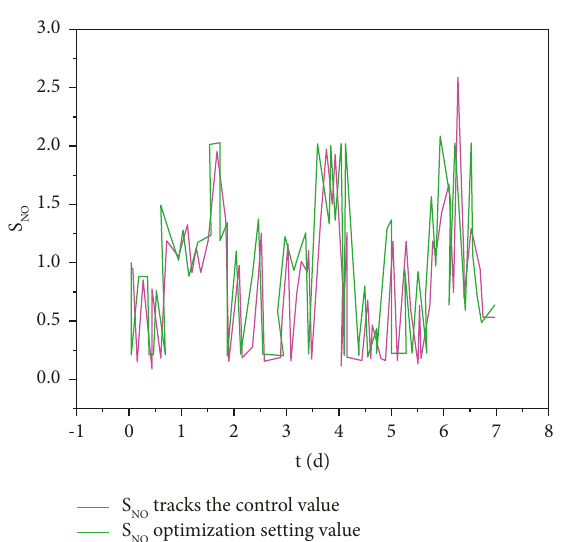
Figure 2: SO tracking control diagram.